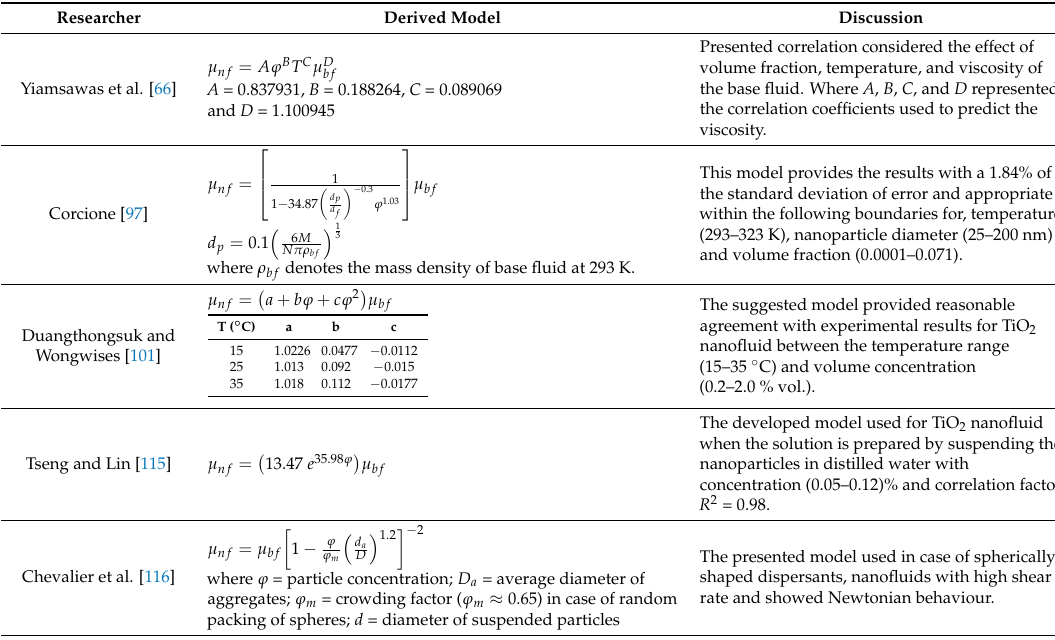
Table 2. Viscosity models for TiO 2